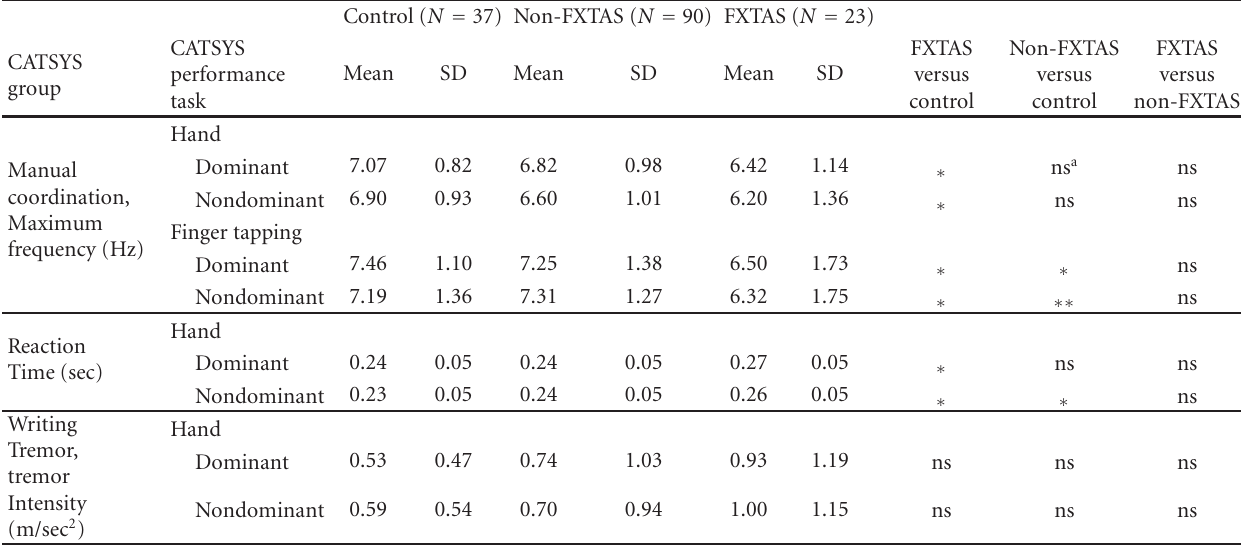
Table 3: Exploratory comparison of secondary outcome CATSYS